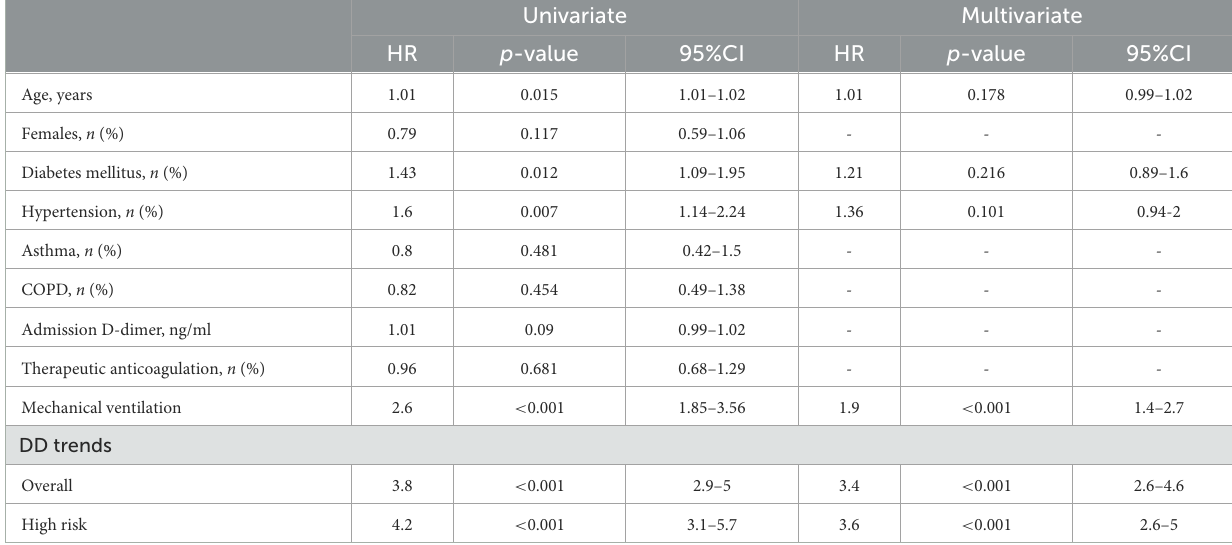
TABLE 4 Overall predictors of in-hospital